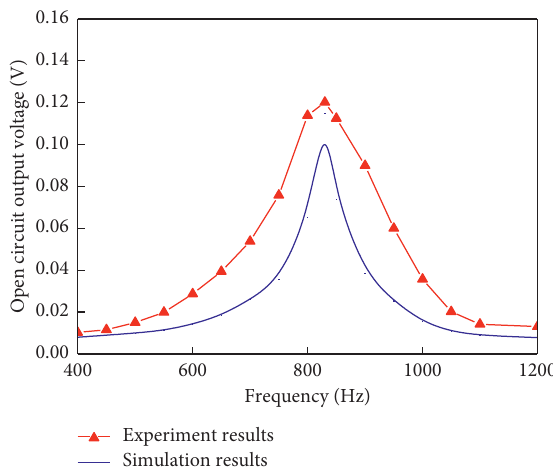
Figure 19: Frequency response of open circuit output